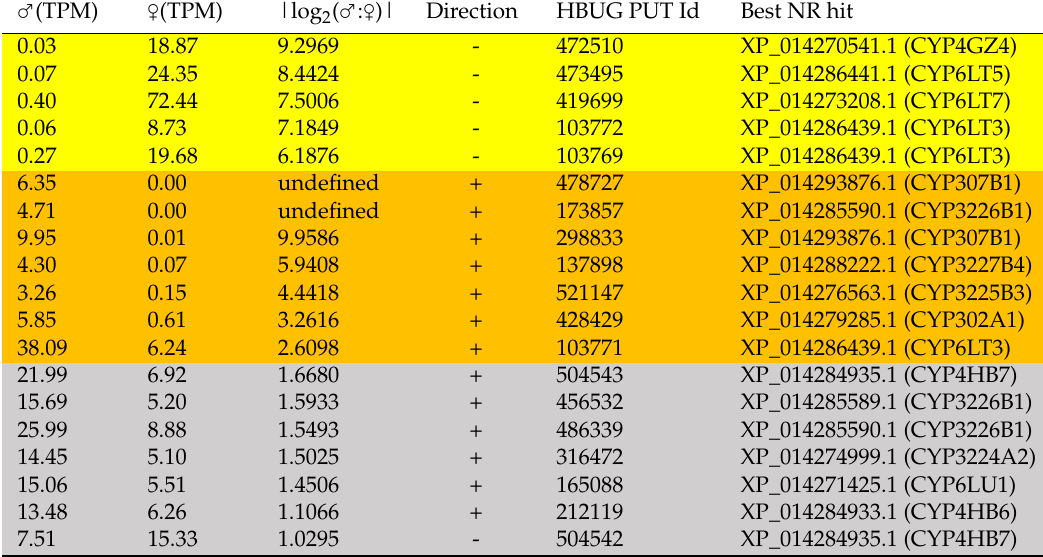
Table 4. M. histrionica PUTs encoding cytochrome P450 enzymes that appear to have sex-preferential expression patterns. Those among the most predominantly expressed in female adults are highlighted in yellow; those more predominantly expressed in males are highlighted in orange; and those having expression values of at least 5 TPM in both sex-specific samples, as well as at least a two-fold expression differential, are presented with grey